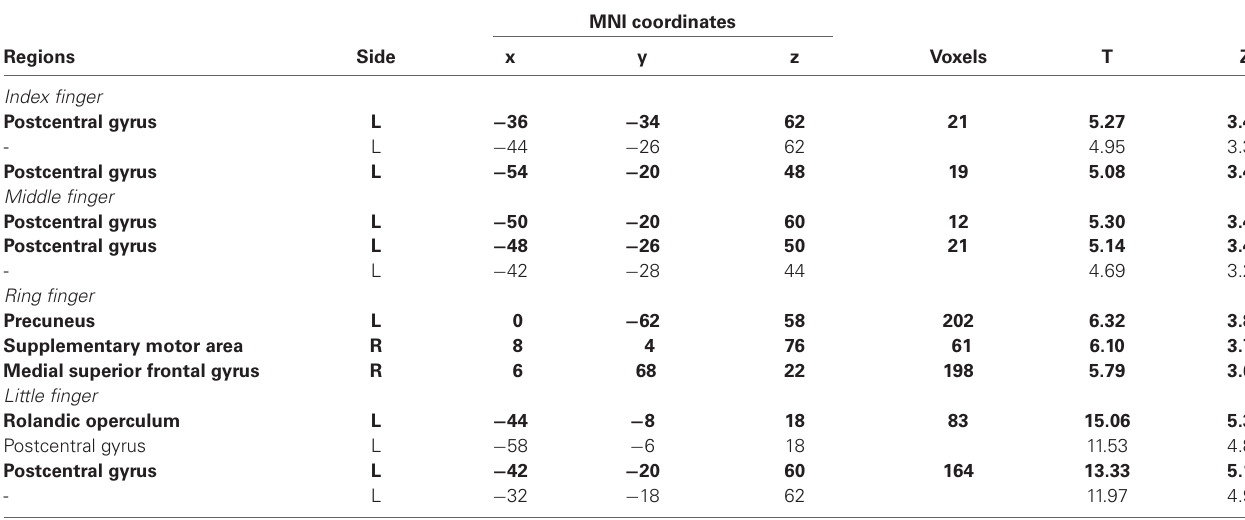
Table 2 | Significant clusters from two-class classification (finger stimulation vs. no stimulation) using searchlight MVPA ( p < 0.001 uncorrected, cluster size > 10).